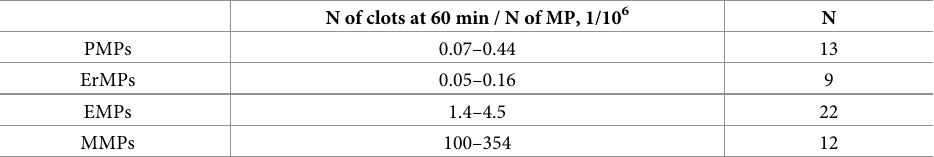
Table 2. The ratio of spontaneous clots number to the number of MPs in the chamber volume. The number of MPs in the chamber volume was estimated based on MPs concentrations and considering the plasma volume where spontaneous clots were counted to be equal to 70 μ l. N–the number of tests included in the calculation. The ranges of values in the table are from the 25th to 75th percentile.